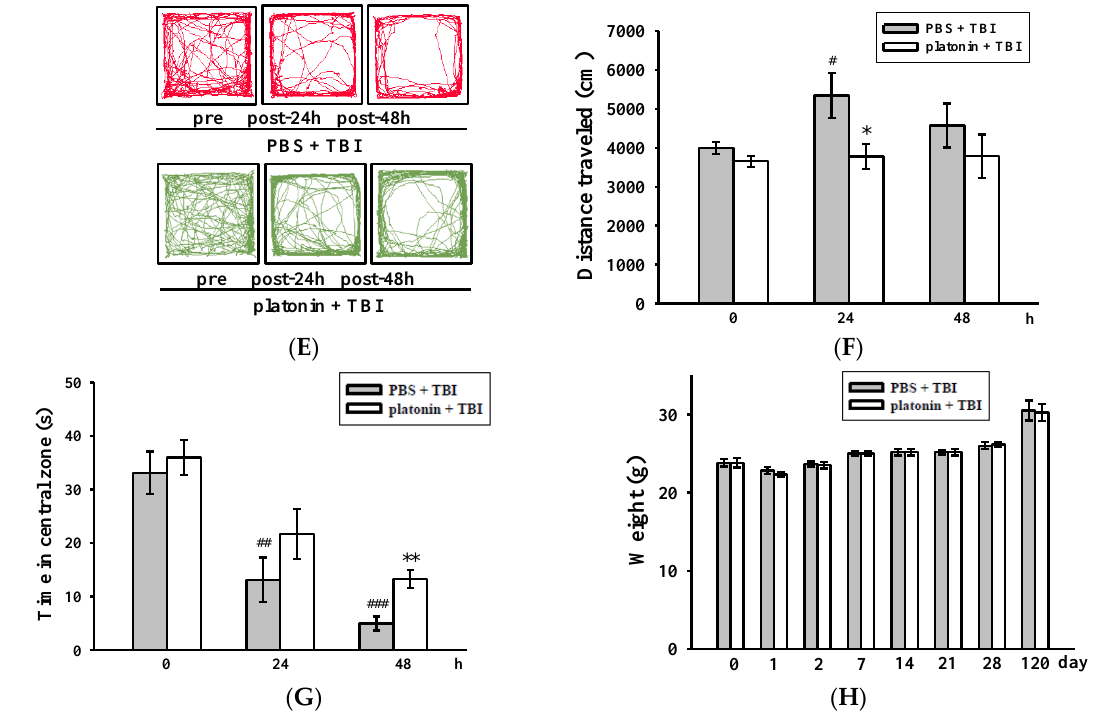
Figure 1. Alleviation of neurobehavioral deficits after platonin treatment in a mouse traumatic brain injury (TBI) model. Mice were treated with an isovolumetric solvent control (phosphate-buffered saline (PBS), intraperitoneally (ip)) or platonin (200 µg/kg, ip) for 30 min and then subjected to TBI). ( A ) The chemical structure of platonin. Assays of neurobehavioral functions including neurological severity scoring ( B ), a rotarod test ( C ), and a grip strength test ( D ) were performed before and 1, 2, 7, 14, 21, 28, and 120 days after TBI. All data are presented as the mean ± SEM ( n = 6). ## p < 0.01, ### p < 0.001, compared to the sham group; * p < 0.05, ** p < 0.01 and *** p < 0.001, compared to the PBS group. Locomotor activity ( E , F ) and anxiety-like behavior ( G ) were evaluated before and 24 and 48 h after TBI. All data are presented as the mean ± SEM ( n = 10). # p < 0.05, ## p < 0.01 and ### p < 0.001, compared to the presurgery group; * p < 0.05 and ** p < 0.01, compared to the PBS group. ( H ) Body weight of mice only treated with the isovolumetric solvent control (PBS, ip) or platonin (200 µg/kg, ip) after TBI, recorded for 0 – 120 days.